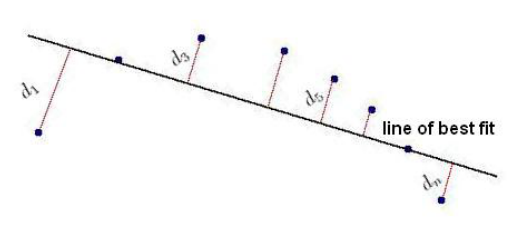
Figure ３ : RMS of Deviation from Line-Of-Best-Fit